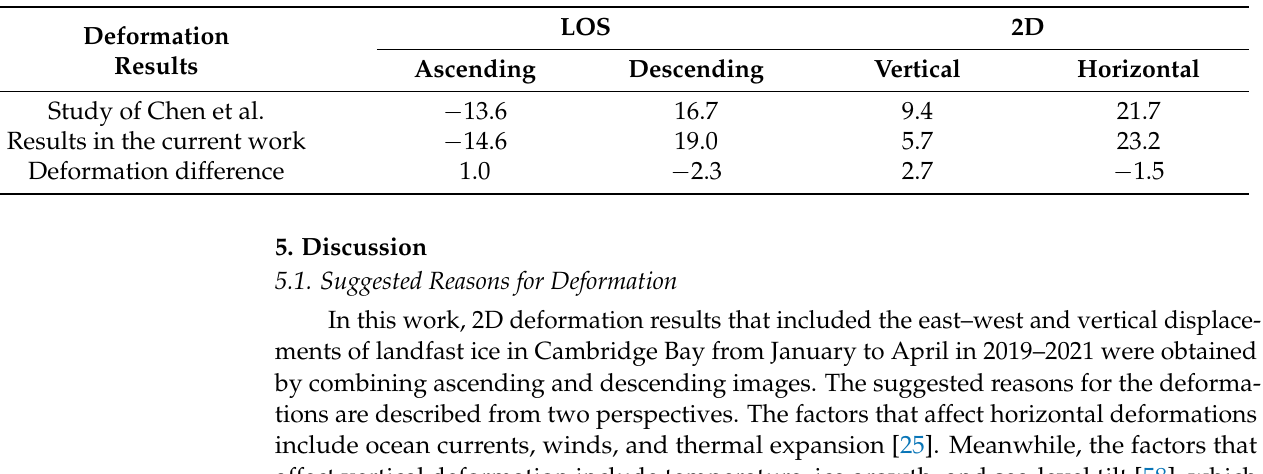
Table 4. Comparison of deformation results (in